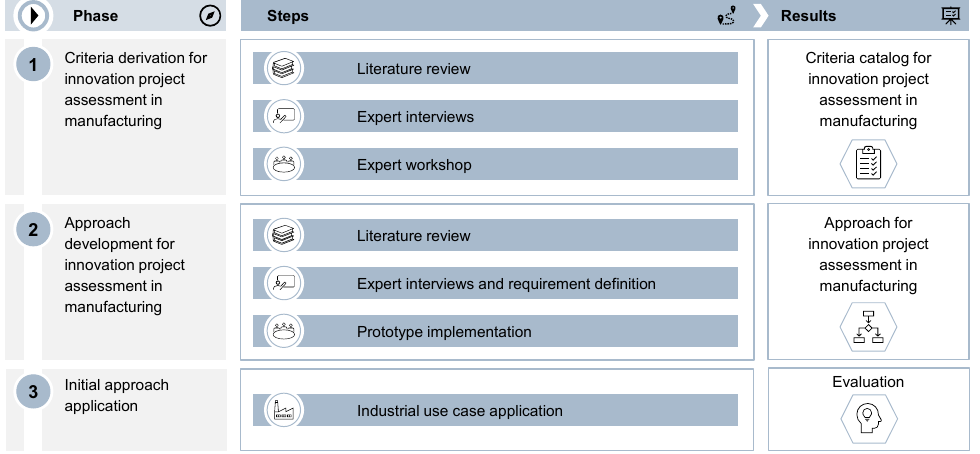
Figure 2. Methodical procedure to derive a holistic assessment approach.